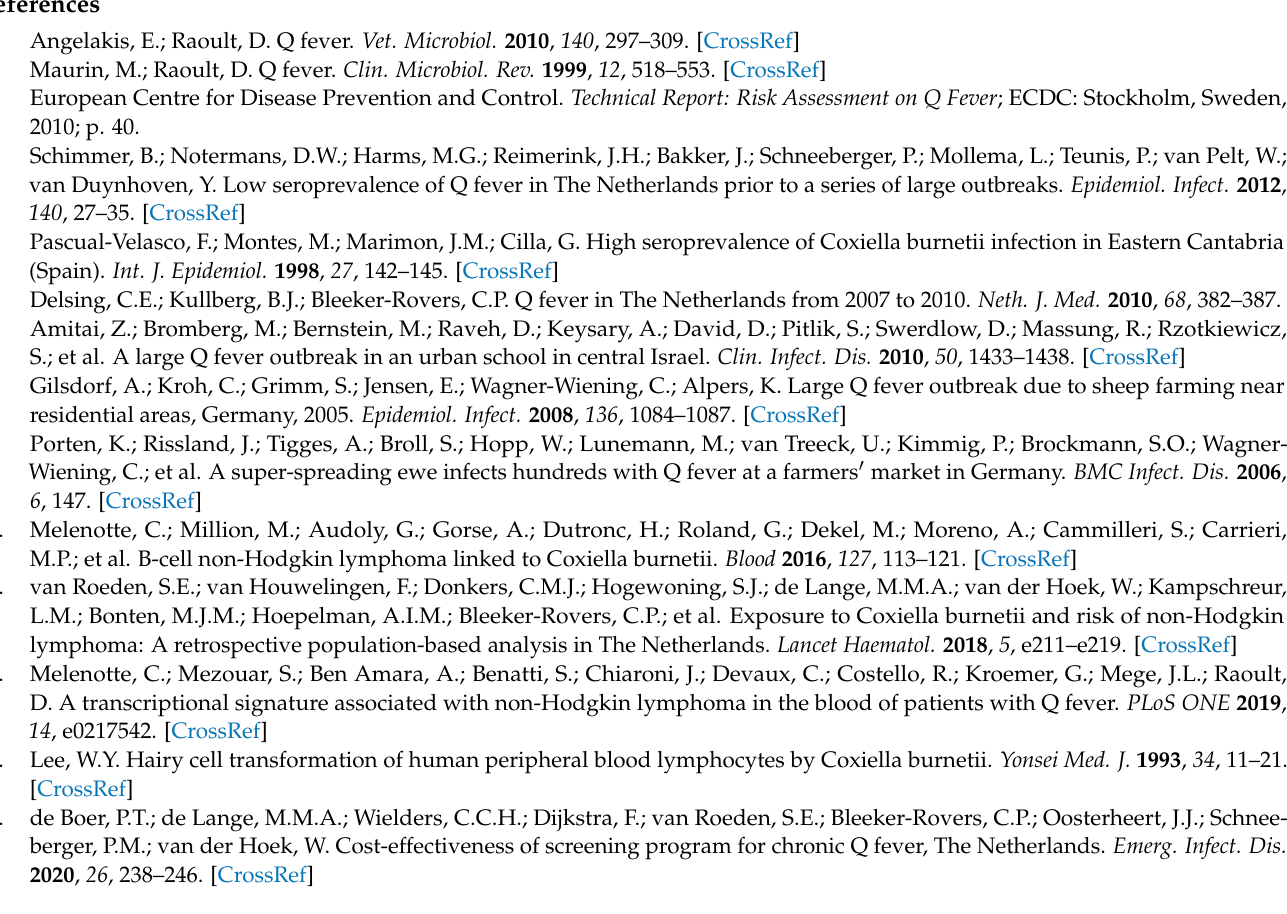
Table S2: Performance of C. burnetii antigens; Table S3: Performance of C. burnetii antigens measured in 28 C. burnetii patients with elevated Phase I endpoint titers; Table S4: multiplex serology assay characteristics and performance of the antigens GroEL and Com1; Figure S1: Antibody levels in the reference population; Figure S2: Antibody responses against Com1 and